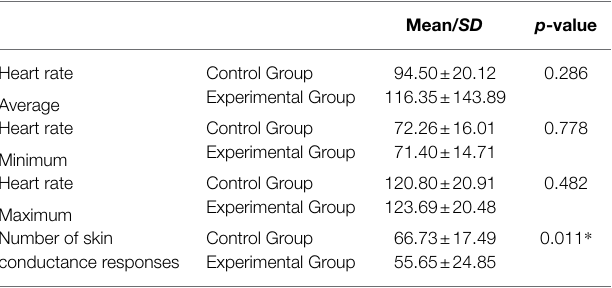
TABLE 5 | Summary of the statistical measures related to Heart Rates and electrodermal activity in the control and experimental groups.